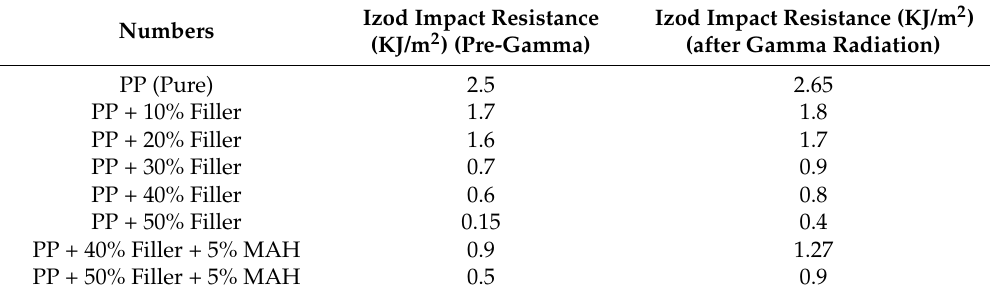
Table 8. Comparative presentation of Izod impact strength findings for polyethylene matrix specimens before and after radiation.